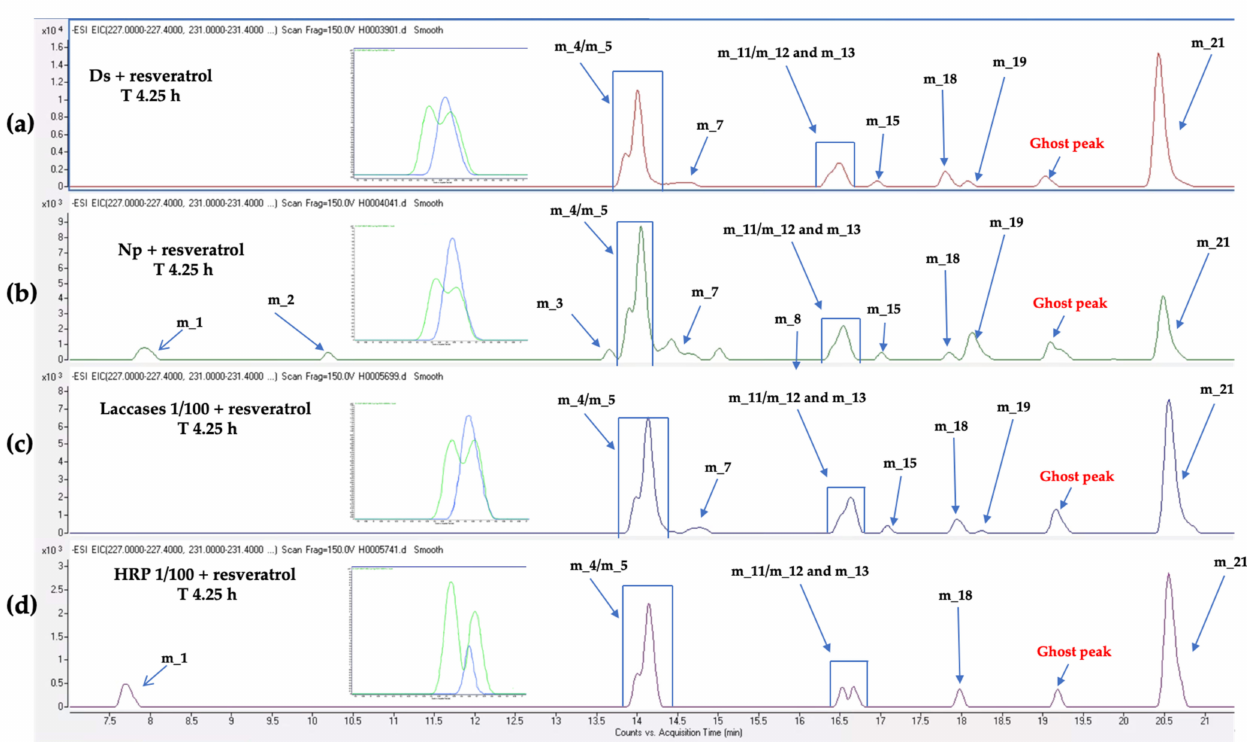
Figure 13. Extracted Ion Chromatogram (EIC) obtained during resveratrol metabolization (5 µ g/mL) after 4.25 h by ( a ) D. seriata extracellular proteins (200 µ g/mL), ( b ) N. parvum (1 mg/mL), ( c ) Aspergillus laccases diluted at 1/100 from a commercial solution (10 LAMU/g, LAMU: quantity of enzyme oxidizing 1 micromole of syringaldazine per minute at pH 7.5 and 30 ◦ C), ( d ) HRP (0.01 mg/mL) + 5 µ L H 2 O 2 . A zoom on m_12/m_13 and m_11 is presented on the left side of each chromatogram. The corresponding ion of pallidol (m_11) is highlighted in blue and that of m_12/m_13 is highlighted in